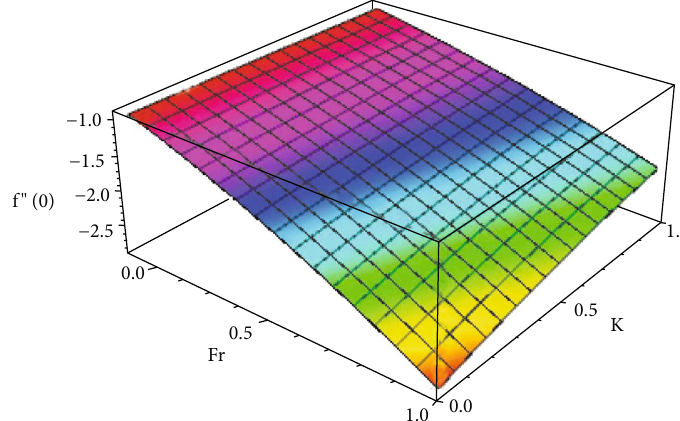
Figure 21: E ff ect of local inertia parameter Fr and couple stress parameter K on skin friction f ′′ ð 0 Þ .